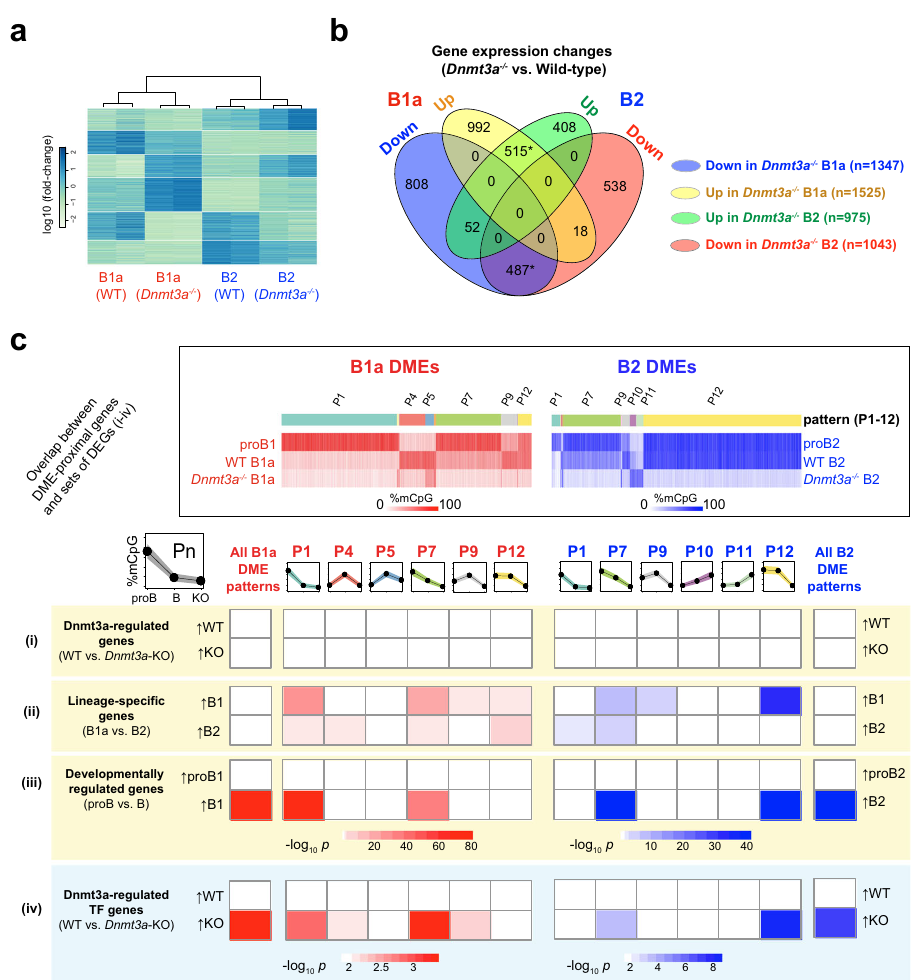
Fig. 7 B-lineage DMEs are maintained in distinct chromatin states in B2 and B1a cells. a Heatmap of differentially expressed genes between wild-type and Dnmt3a -/- B1a and B2 cells (two replicates per condition). b Genes differentially expressed between wild-type and Dnmt3a -/- B1a and B2 cells are shown as a Venn diagram. Statistically signi fi cant overlaps ( p < 2.2e-16, Fisher ’ s exact test) are marked with an asterisk. c Signi fi cance of overlap between genes in the proximity of B1a and B2 DMEs exhibiting distinct patterns of methylation and the following differentially expressed sets of genes (i) all genes whose expression is altered by the loss of Dnmt3a in B1a and B2 cells, or (ii) B2 and B1a lineage-speci fi c genes, or (iii) genes whose expression is altered during development (from proB to mature B), or (iv) genes encoding transcription factors whose expression is altered by the loss of Dnmt3a . The signi fi cance of the overlap was assessed using two-sided Fisher ’ s exact test and signi fi cantly overlapping pairs of gene sets ( p < 0.001) are colored in pink (B1) or blue (B2) based on the p -value. Source data are provided as a Source Data fi